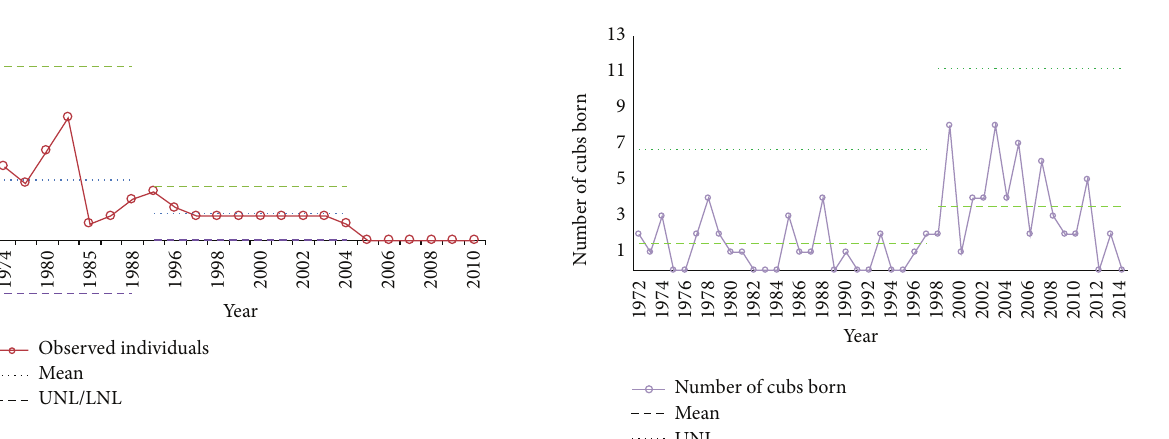
Figure 4: Observation data for the Po’ouli ( Melamprosops phaeo- soma ) on Maui, Hawaii (data from [11, 23]). Mean and natural limits are calculated for 1974–1988 (left) and 1988–2004 (centre).